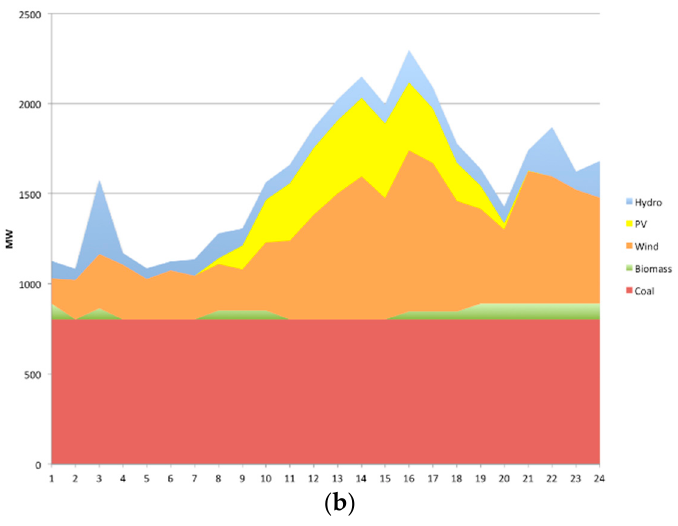
Figure 9. Generation profile—SARD ( a ) winter and ( b ) summer.